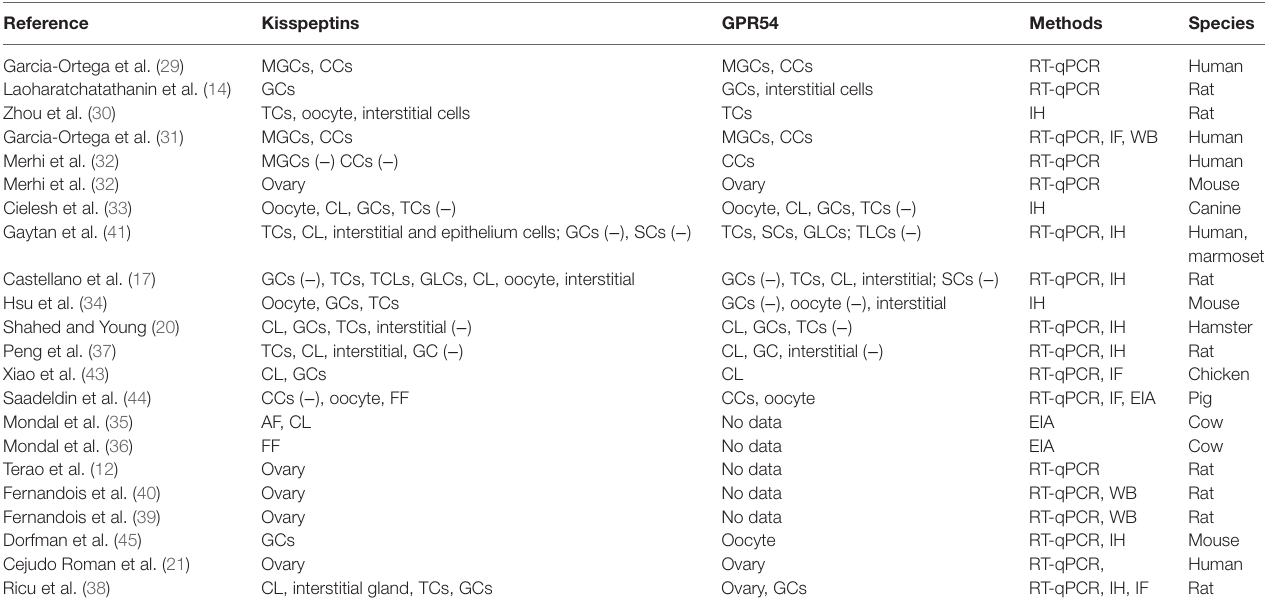
TAble 1 | Expression of the kisspeptin/kisspeptin receptor system in the ovary.